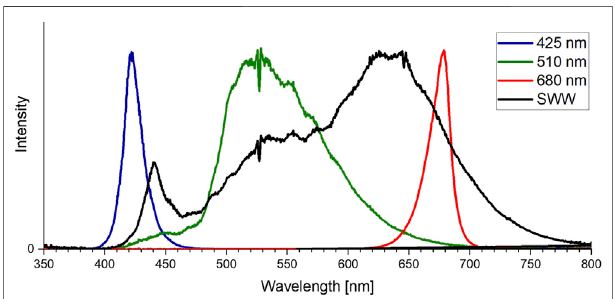
FIGURE 1 | Light-emitting diode (LED) intensities (425 nm, 510 nm, 680 nm and SWW) used for color growth experiments. Ocean optic spectrometer data was normalized to fi t the 425 nm peak.